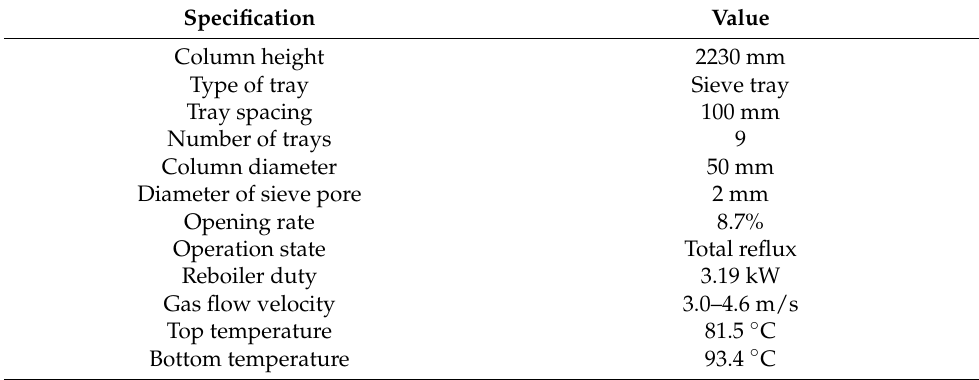
Table 1. The geometrical parameters of the sieve tray distillation columns and operational